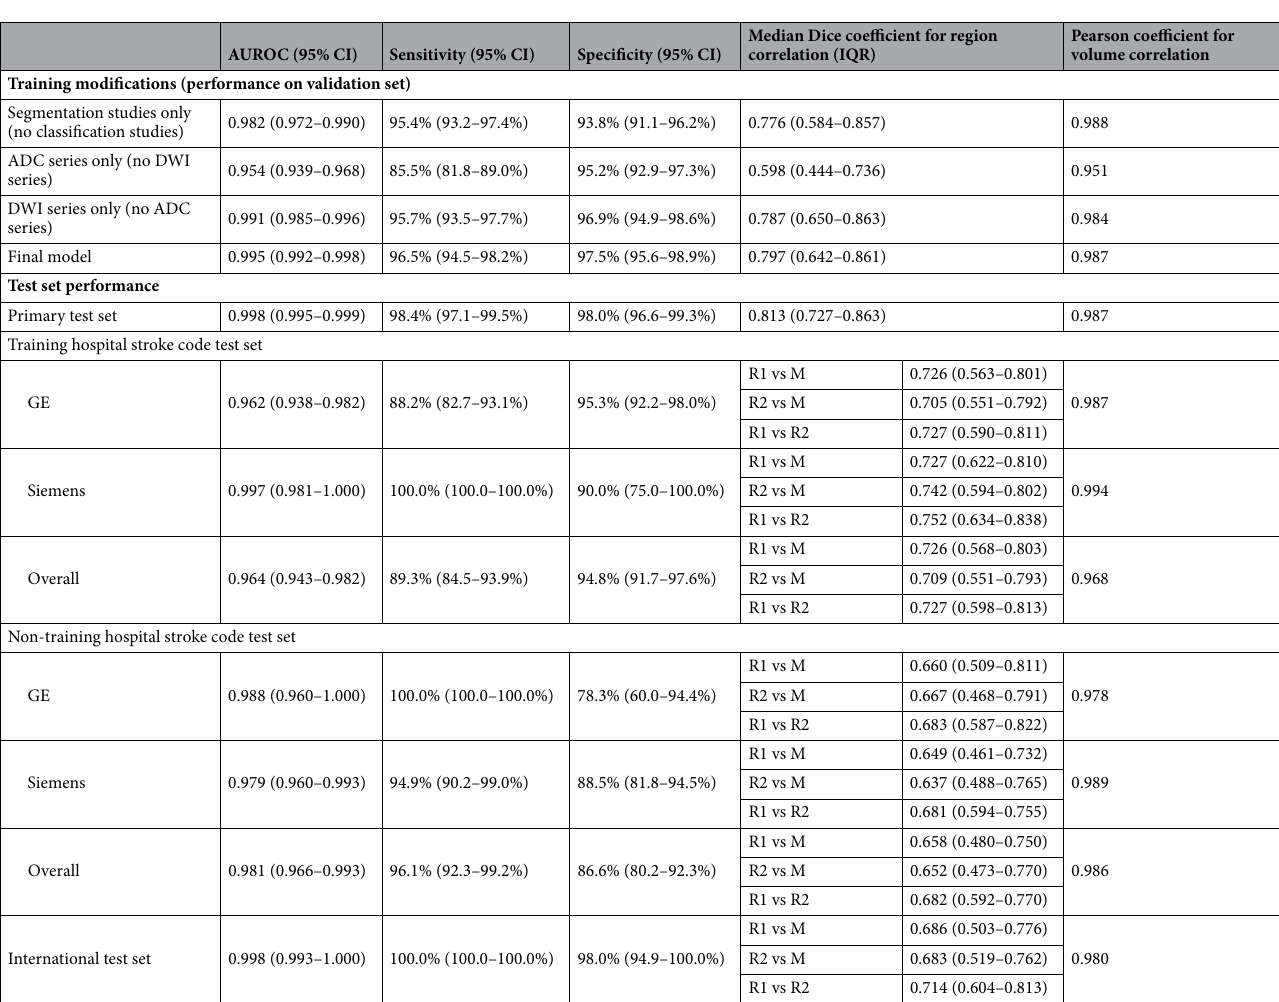
Table 2. Results summary: The model results obtained during training and testing. As there were two ground truth readers for the stroke code and international test sets, there are three Dice coefficients (reader 1 vs model